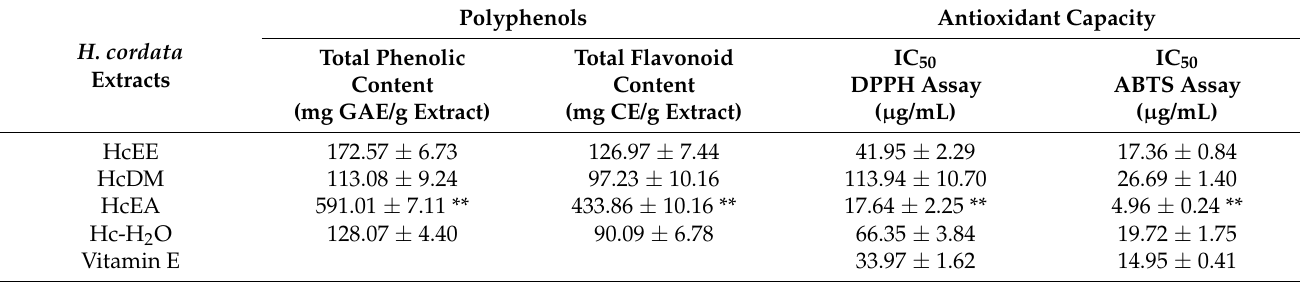
Table 1. Total phenolic contents, total flavonoid contents, and antioxidant activities of H. cordata